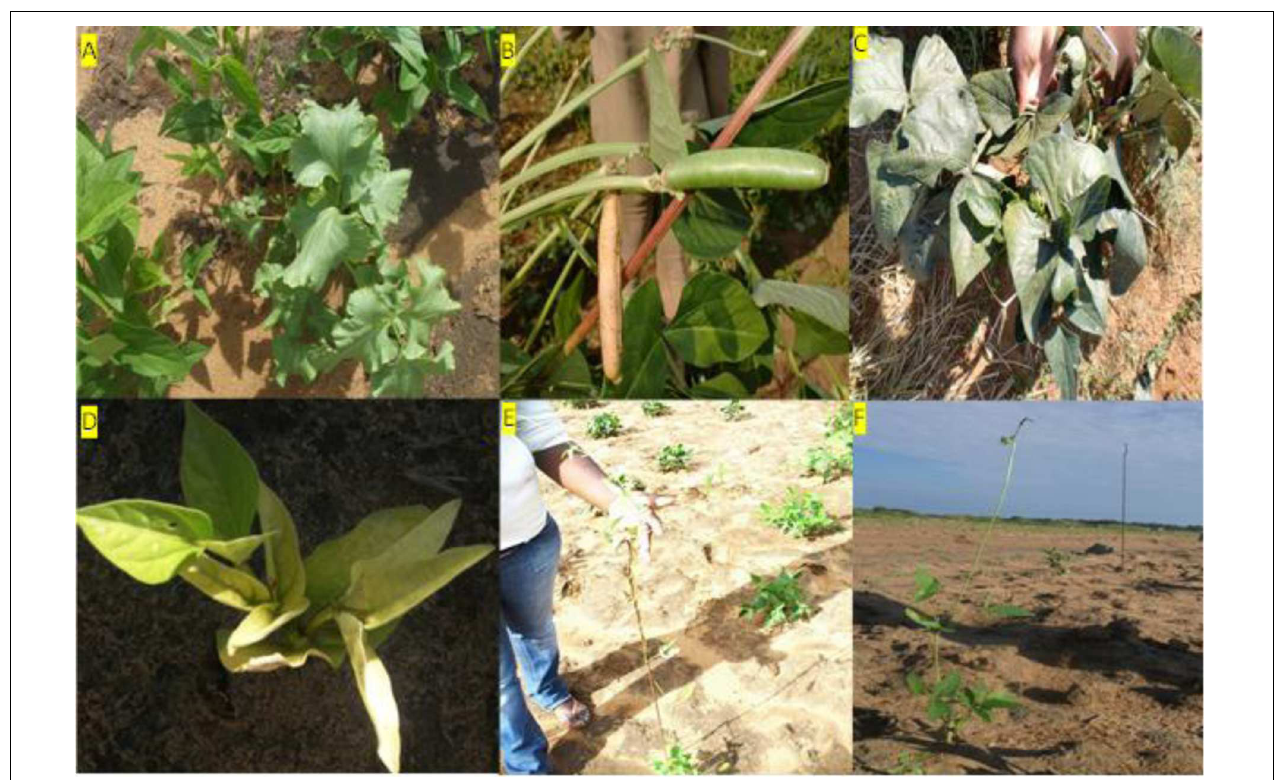
FIGURE 2 | Some common abnormalities at M 3 observed at Bagani Research Station. (A) spinach-like leaves, (B) Short-pods, (C) broad-dark leaves, (D) chlorophyll mutant, -single stem (E,F) observed at Omahenene research Station.